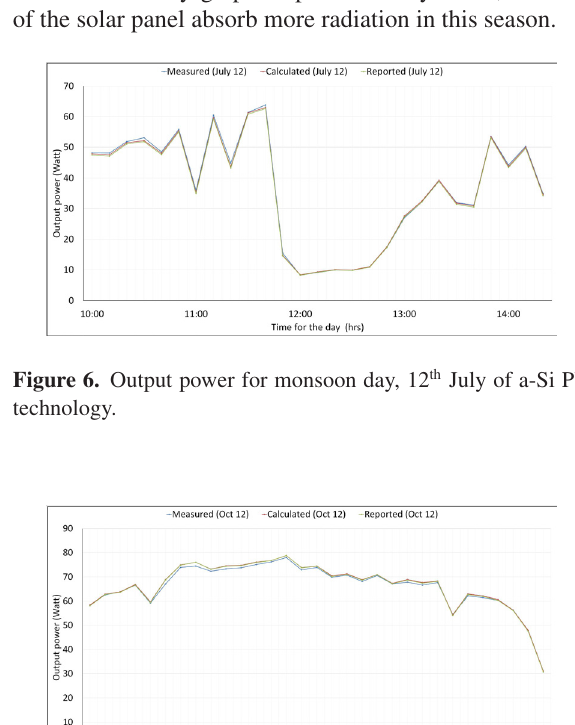
Figure 7. Output power for clear sky day, 12 th Oct of a-Si PV